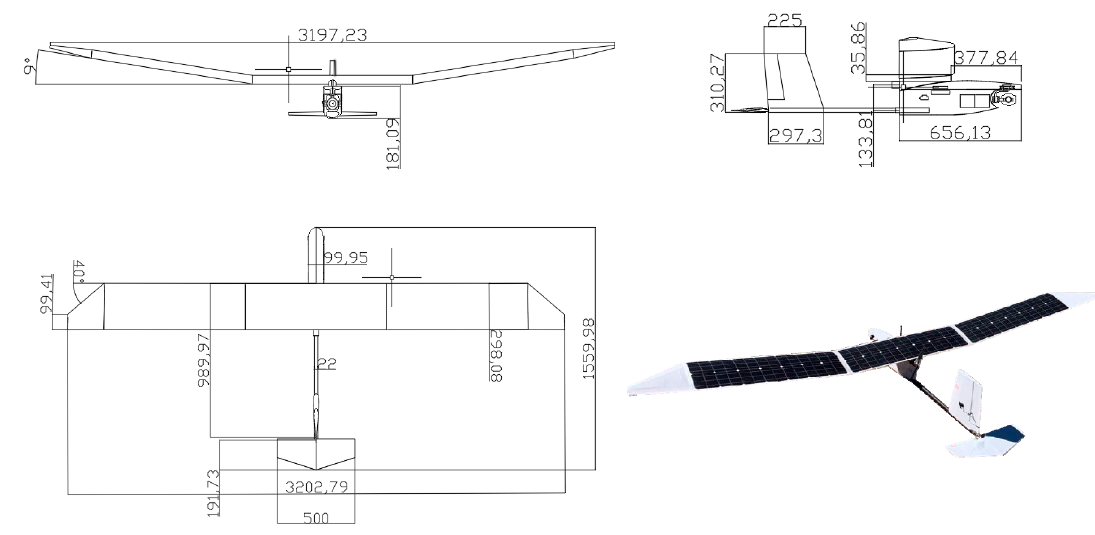
Figure 6. The Mini-Phantom Solar UAV. Dimensions are given in mm.